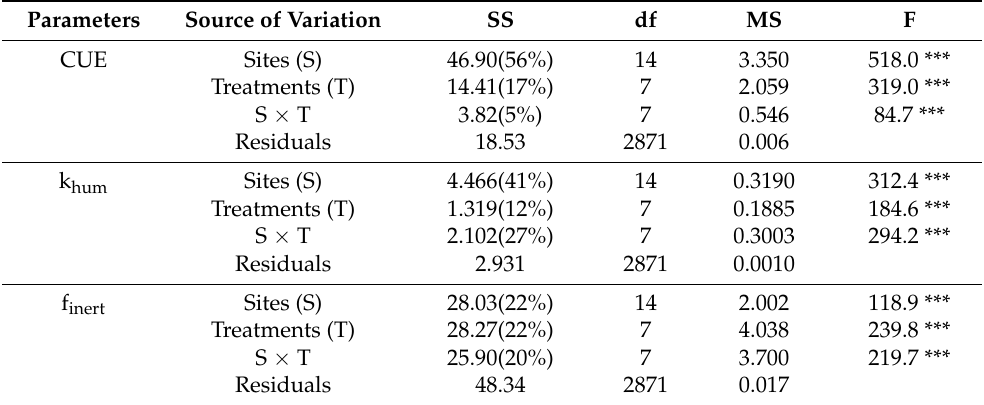
Table 2. ANOVA analysis of three optimized model parameters under different treatments at different sites.